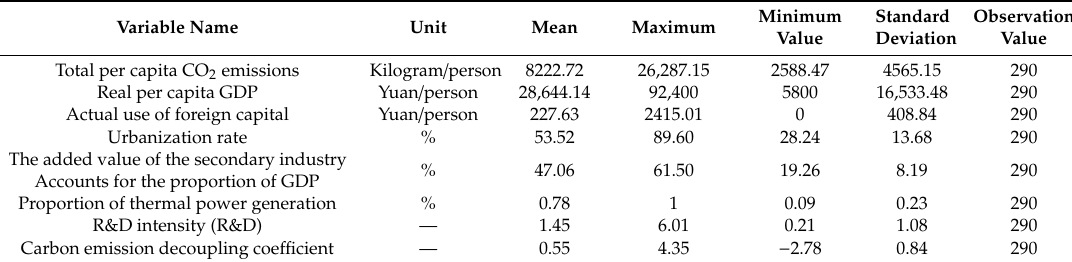
Table 2. Descriptive statistics of the variables.